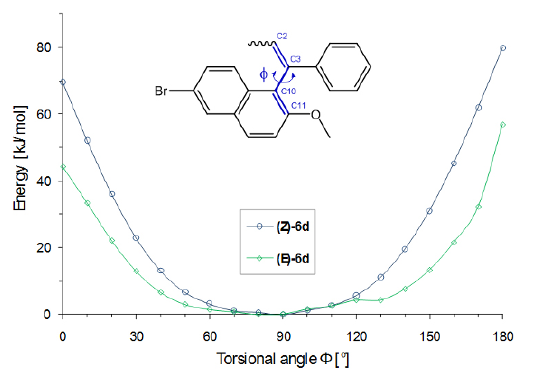
Figure 3. Calculated potential curves for rotation around the C2-C3-C10-C11 torsion angle ( Φ ) for both diastereomers of 6d using the AM1 method.